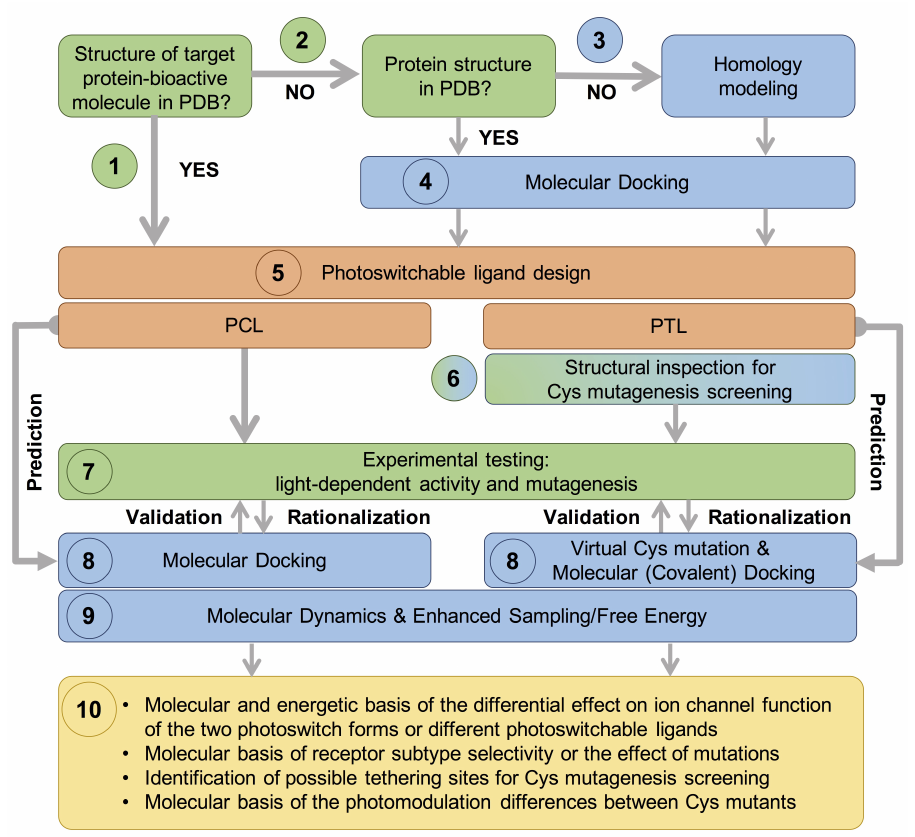
Figure 3. Proposed workflow for rational, structure-based design of photoswitchable ligands. The de- sign step is indicated in orange, the experimental steps in green and the computational steps in blue. Ligand-based data (such as structure–activity relationship data or information about tethered, non-photoswitchable ligands), though not shown here, can also be integrated in the design step. Some of the possible information outcomes of this integrative computational-experimental workflow are listed in the yellow